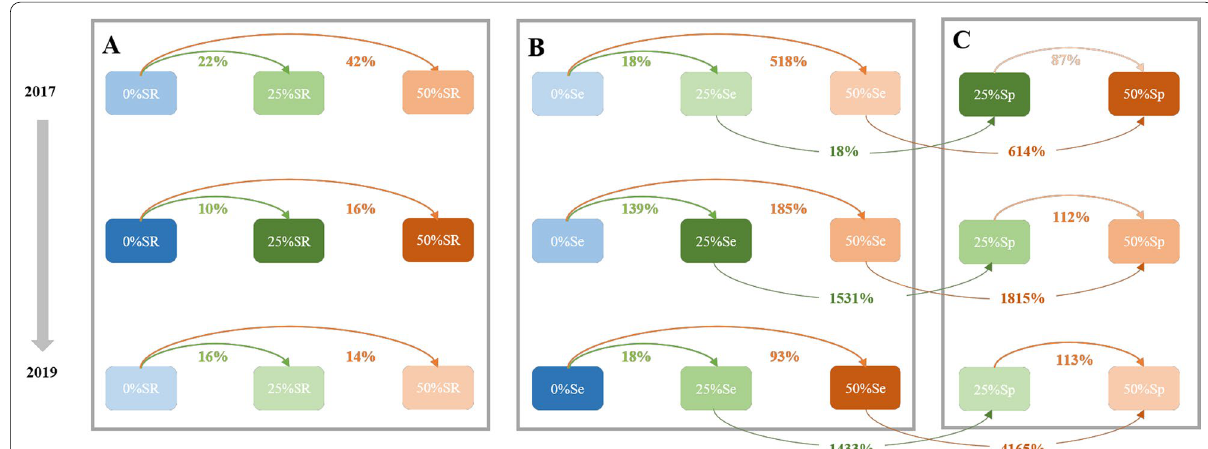
Fig. 7 Conceptual framework of the conclusion. Only results that differ between logging treatments are shown in this figure. A – C are the effects of logging intensity on the density of seed rain (SR), seedlings (Se) and sprouts (Sp), respectively. Blocks from top to bottom represent the different years after logging (from 2017 to 2019), and the color gradation of blocks from dark to light color indicates decreasing size of density in the same logging intensity treatment. The percent on pointers is a ratio between the density of seed rain/seedlings/sprouts in control (0% logging intensity), 25% logging intensity (25% of the basal area removal) and 50% logging intensity (50% of the basal area removal), and the proportional relationships between seedling and sprout density at the same logging